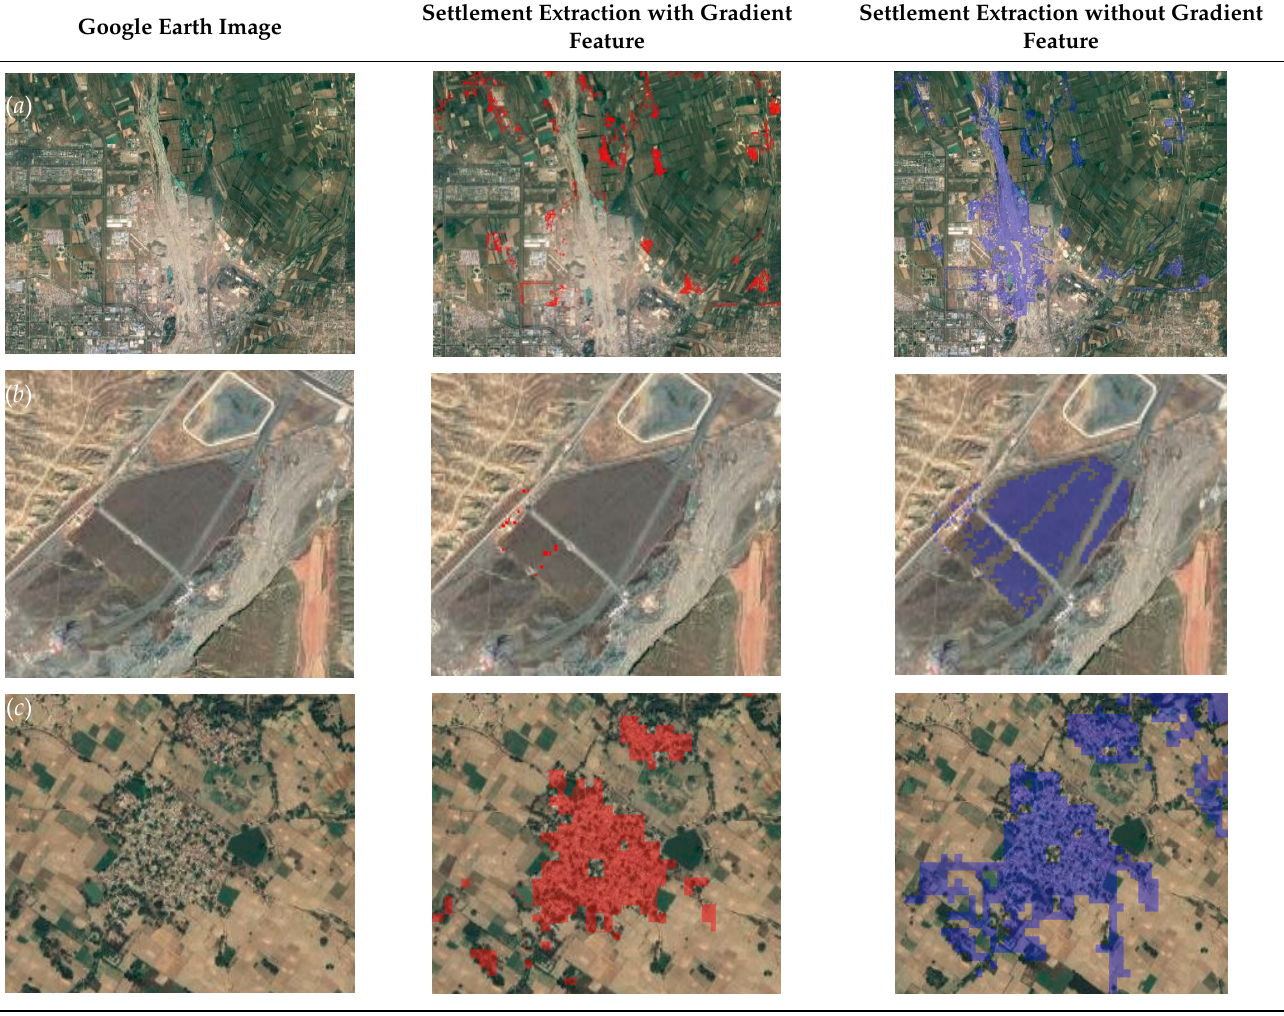
extent. The compared results were shown in Table 4, with red and light blue representing settlement results with or without gradient features. We can see that large areas of bare soil in the sandy region were removed as illustrated in (a) and (b) in Table 4. In addition, the Table 4. Examples of soil-minimization using gradient feature for three selected cases for (a), (b) and (c). Table 4. Examples of soil-minimization using gradient feature for three selected cases for (a), (b) and (c). Table 4. Examples of soil-minimization using gradient feature for three selected cases for (a), (b) and (c). bare soil among cropland was also moderately removed as displayed in Table 4 (c). Table 4. Examples of soil-minimization using gradient feature for three selected cases for (a), (b) and (c). Table 4. Examples of soil-minimization using gradient feature for three selected cases for (a), (b) and (c). Table 4. Examples of soil-minimization using gradient feature for three selected cases for (a), (b) and (c). Table 4. Examples of soil-minimization using gradient feature for three selected cases for (a), (b) and (c). Table 4. Examples of soil-minimization using gradient feature for three selected cases for (a), (b) and (c). Table 4. Examples of soil-minimization using gradient feature for three selected cases for (a), (b) and (c). Google Earth Image Google Earth Google Earth Image Table 4. Examples of soil-minimization using gradient feature for three selected cases for (a), (b) and (c). Google Earth Image Google Earth Image Google Earth Image Google Earth Image Google Earth Image Google Earth Image Google Earth Image